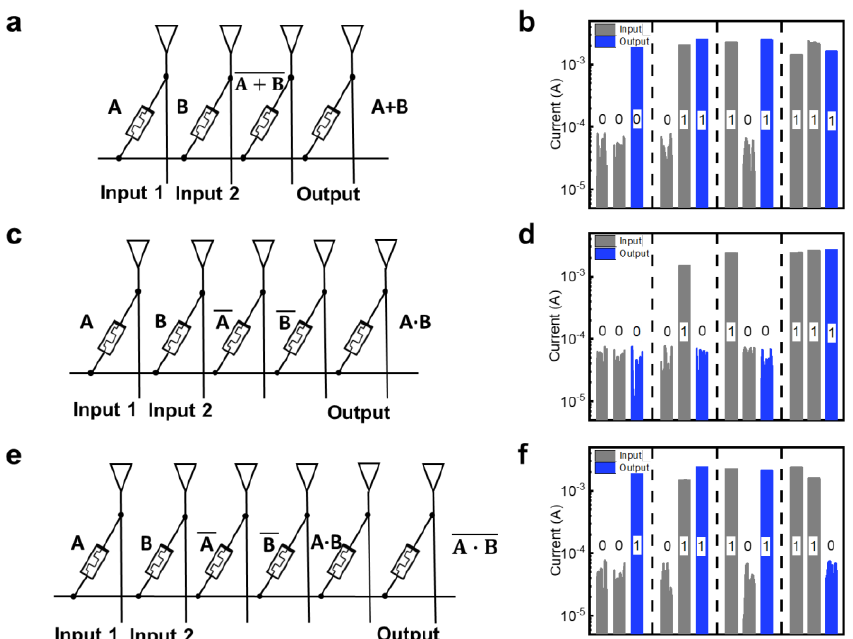
Figure 4. ( a ) OR logic gate within memristor crossbar array and its equivalent circuit. ( b ) Experimental result of OR logic gate. ( c ) AND logic gate within memristor crossbar array and its equivalent circuit. ( d ) Experimental result of AND logic gate. ( e ) NAND logic gate within memristor crossbar array and its equivalent circuit. ( f ) Experimental result of NAND logic gate.